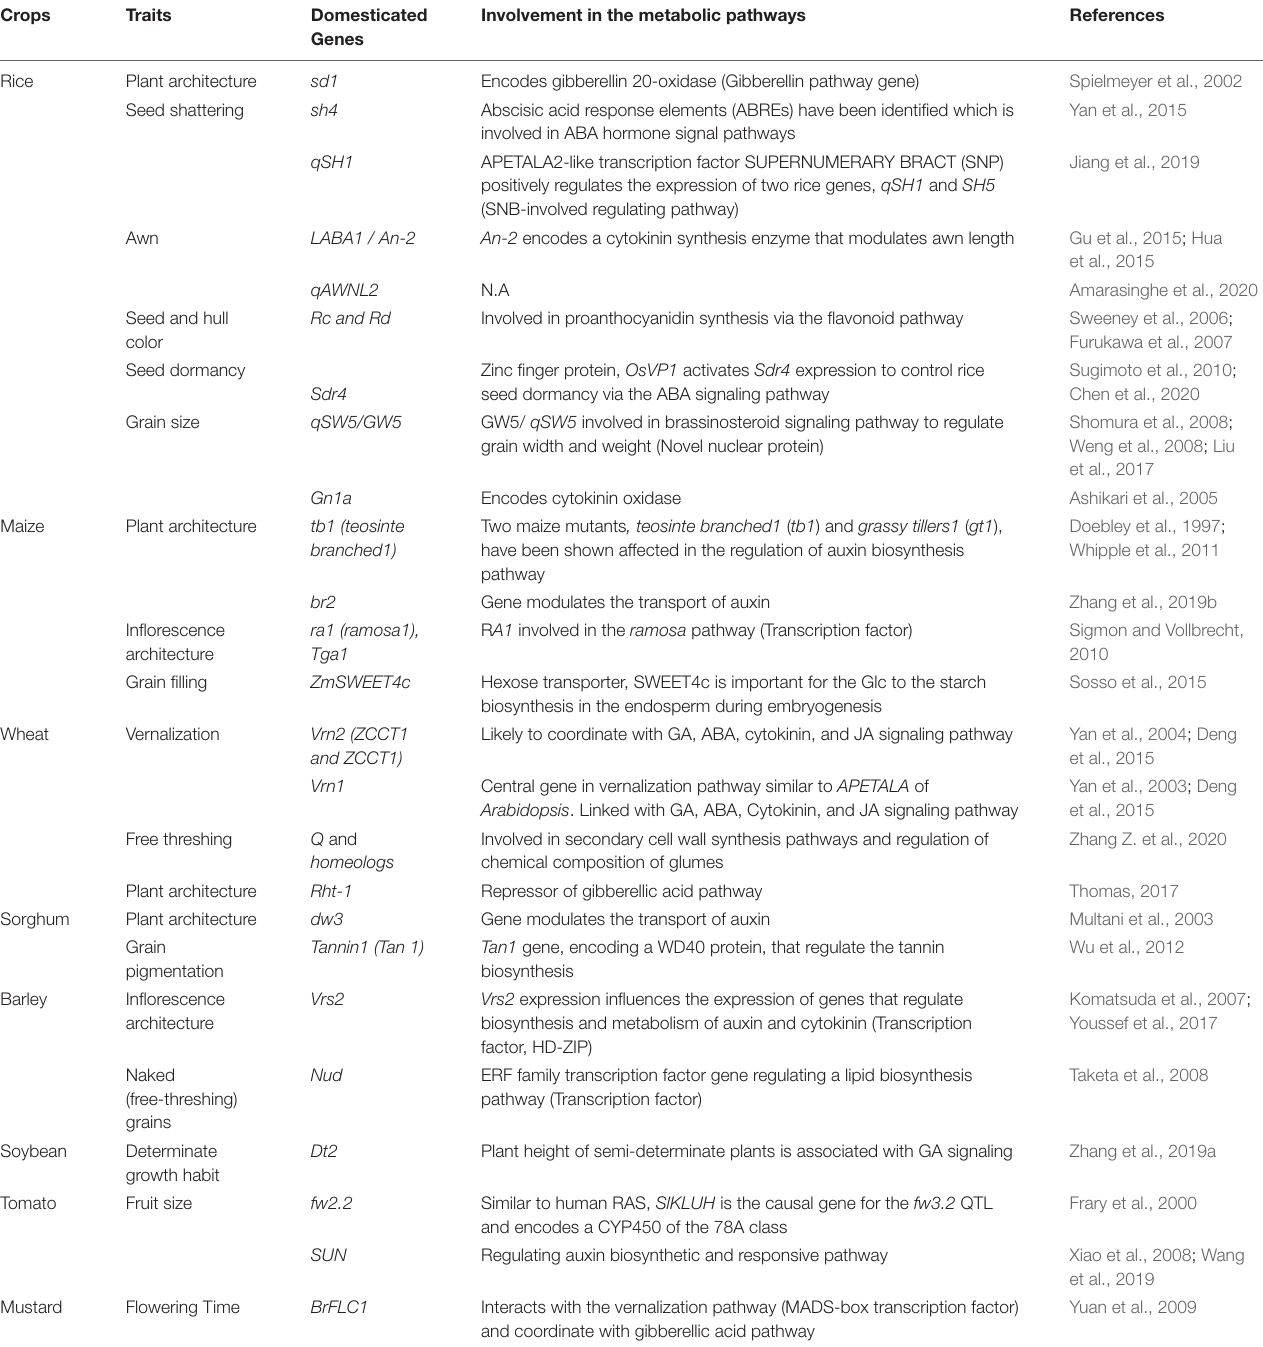
TABLE 4 | List of genes domesticated in the past and associated metabolic pathways.